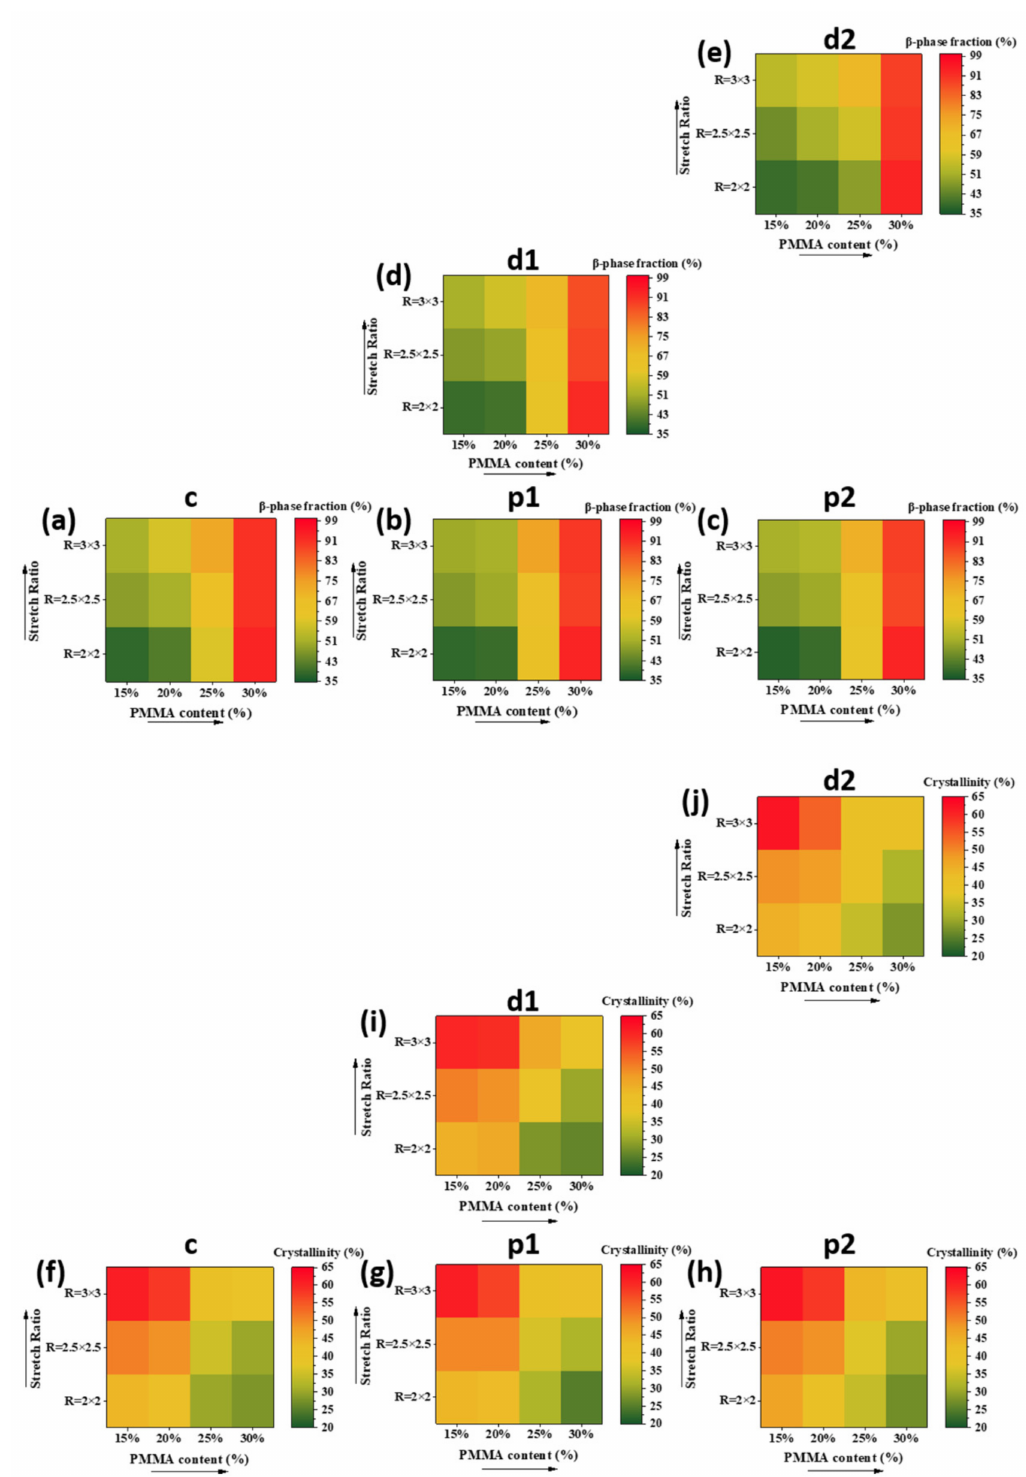
Figure 7. β phase fractions versus PMMA content and stretching ratio for the directions of ( a ) c, ( b ) p1, ( c ) p2, ( d ) d1 and ( e ) d2. And crystallinities versus PMMA content and stretching ratio for the locations of ( f ) c, ( g ) p1, ( h ) p2, ( i ) d1 and ( j ) d2. The second Piola-Kirchhoff stress tensor S a can be